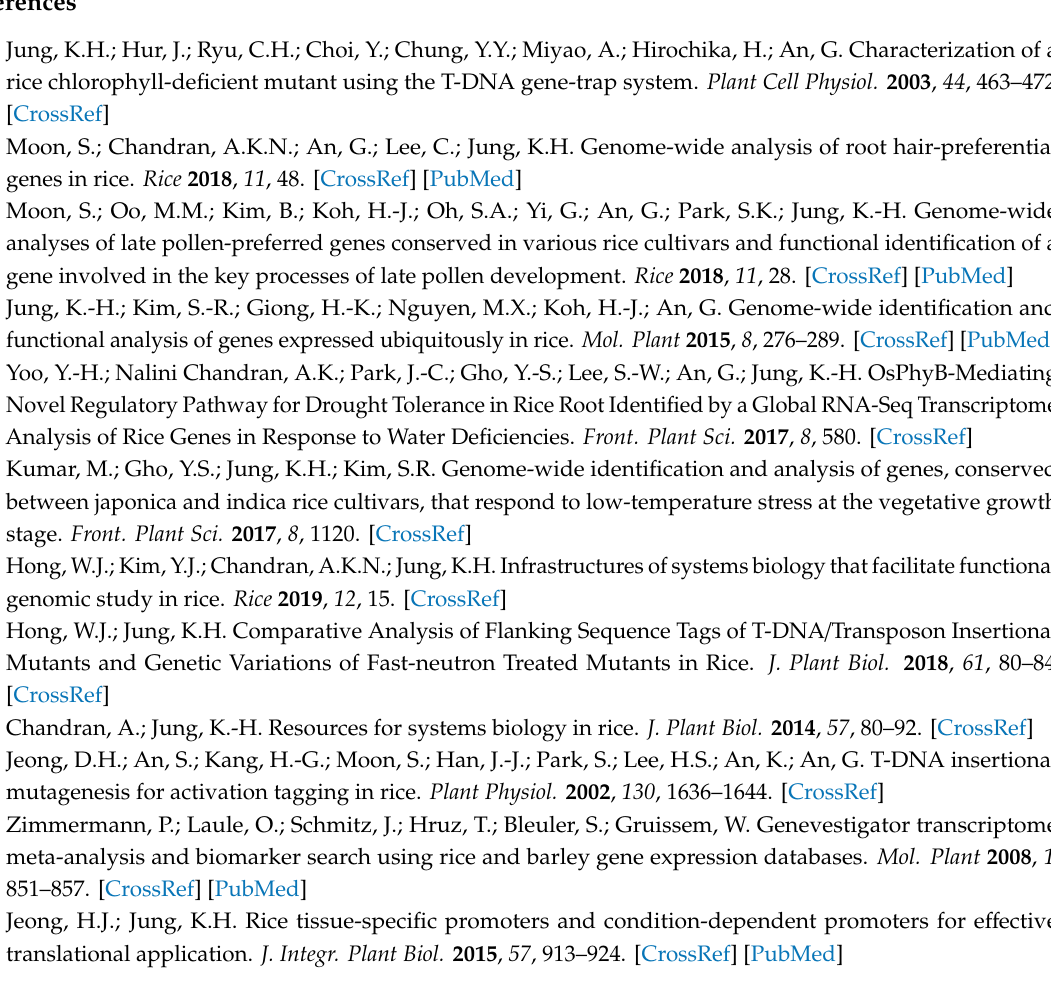
Table S1. Microarray data on genes strongly associated with leaves / flag leaves / shoots, roots / root hairs, seeds / embryos / endosperm, anthers / pollen, and all organs. Table S2. List of potential promoter trap lines selected from organ- or abiotic stress-specific expression patterns. Table S3. RNA-seq data of genes showing increased expression in response to drought stress. Table S4. Microarray data of genes showing increased expression in response to cold stress. Table S5. Primer sequences used for genotyping and qRT-PCR. Figure S1. Heat map analysis of cold stress-responsive genes. We used a KMC algorithm with a Euclidean distance matrix to cluster abiotic stress-responsive genes. To define stress responsiveness, we applied the following criteria: greater than an average of 1 log 2 -fold change (2-fold) for each stress and a p -value less than 0.05 according to one-way ANOVA. As a result, we identified 100 cold stress-responsive genes. Red indicates upregulation under stress vs. control; green indicates downregulation under stress vs. control. Genes identified previously are marked by red arrows. Detailed data on abiotic stress expression analysis are presented in Table